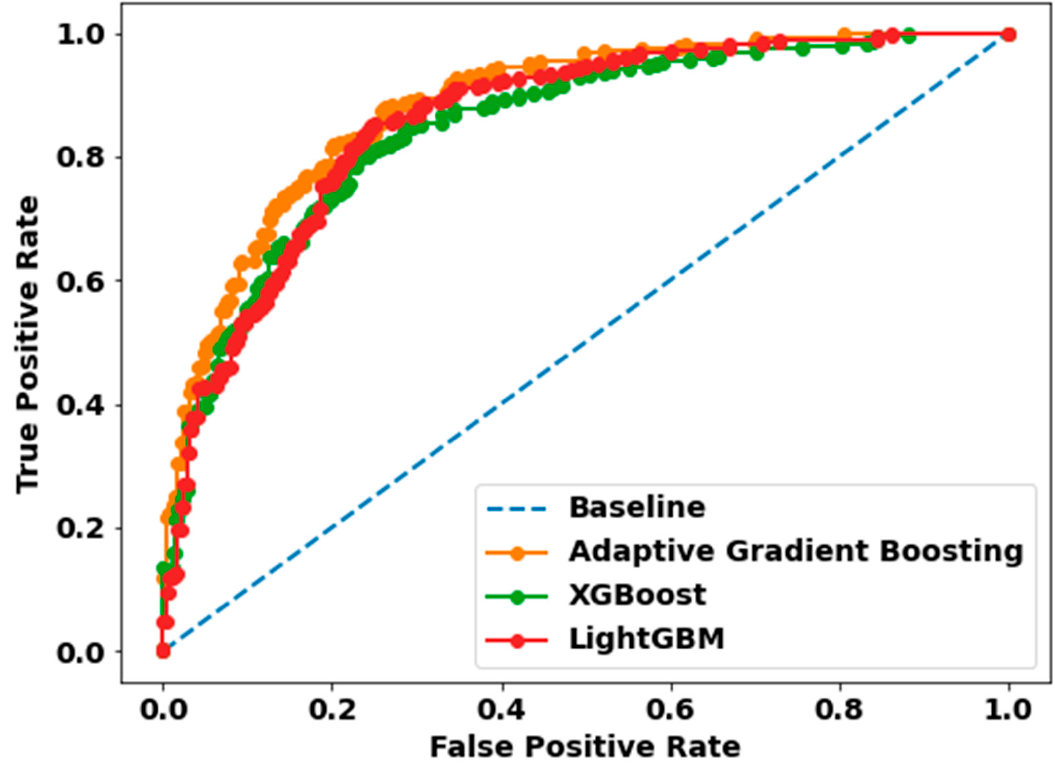
Figure 3. Receiver Operating Characteristic (ROC) curves of the Adaptive Gradient Boosting, XG- Boost, and LightGBM classification models. The orange ROC curve represents Adap-tive Gradient Boosting with AUC (80%), the green ROC curve denotes XGBoost with AUC (77%), and the red ROC curve refers to LightGBM with AUC (78%). The area under the ROC curve (AUC) indicates the accuracy of a prediction. The diagonal blue dot line is the reference line.